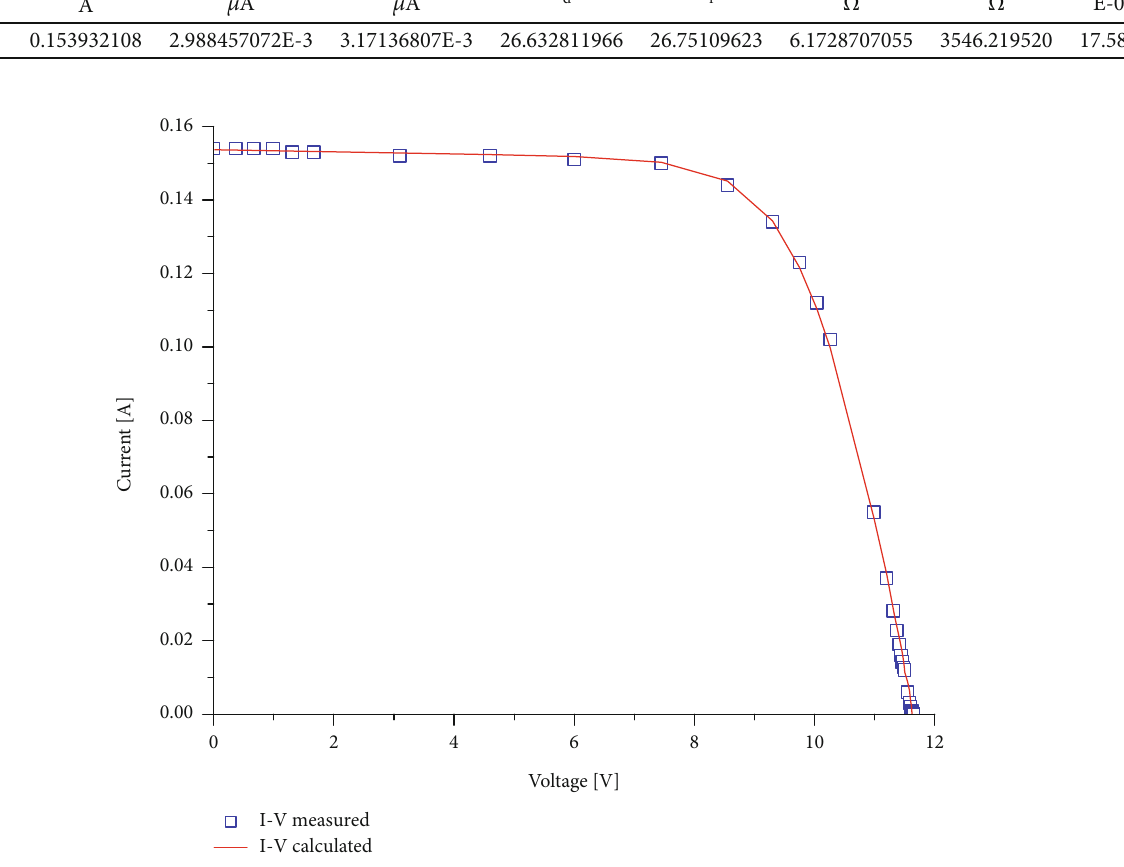
Figure 11: The I-V characteristics for LSM 20 photovoltaic panel.